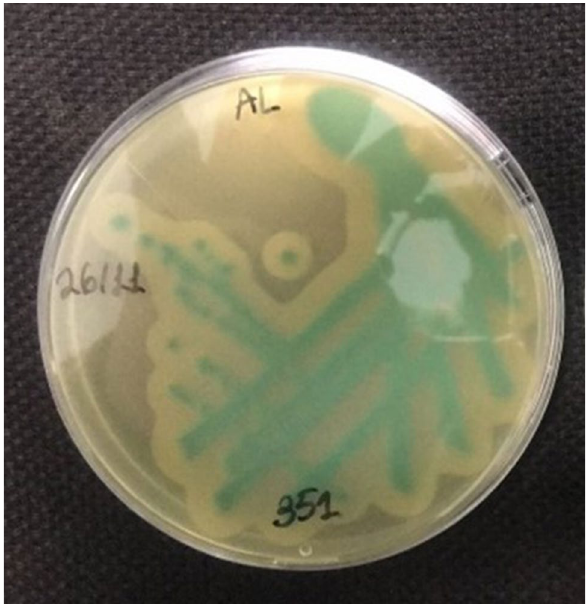
Figure 1. Listeria monocytogenes colonies after cultivation on Tryptone soya yeast extract (TSYE) agar.